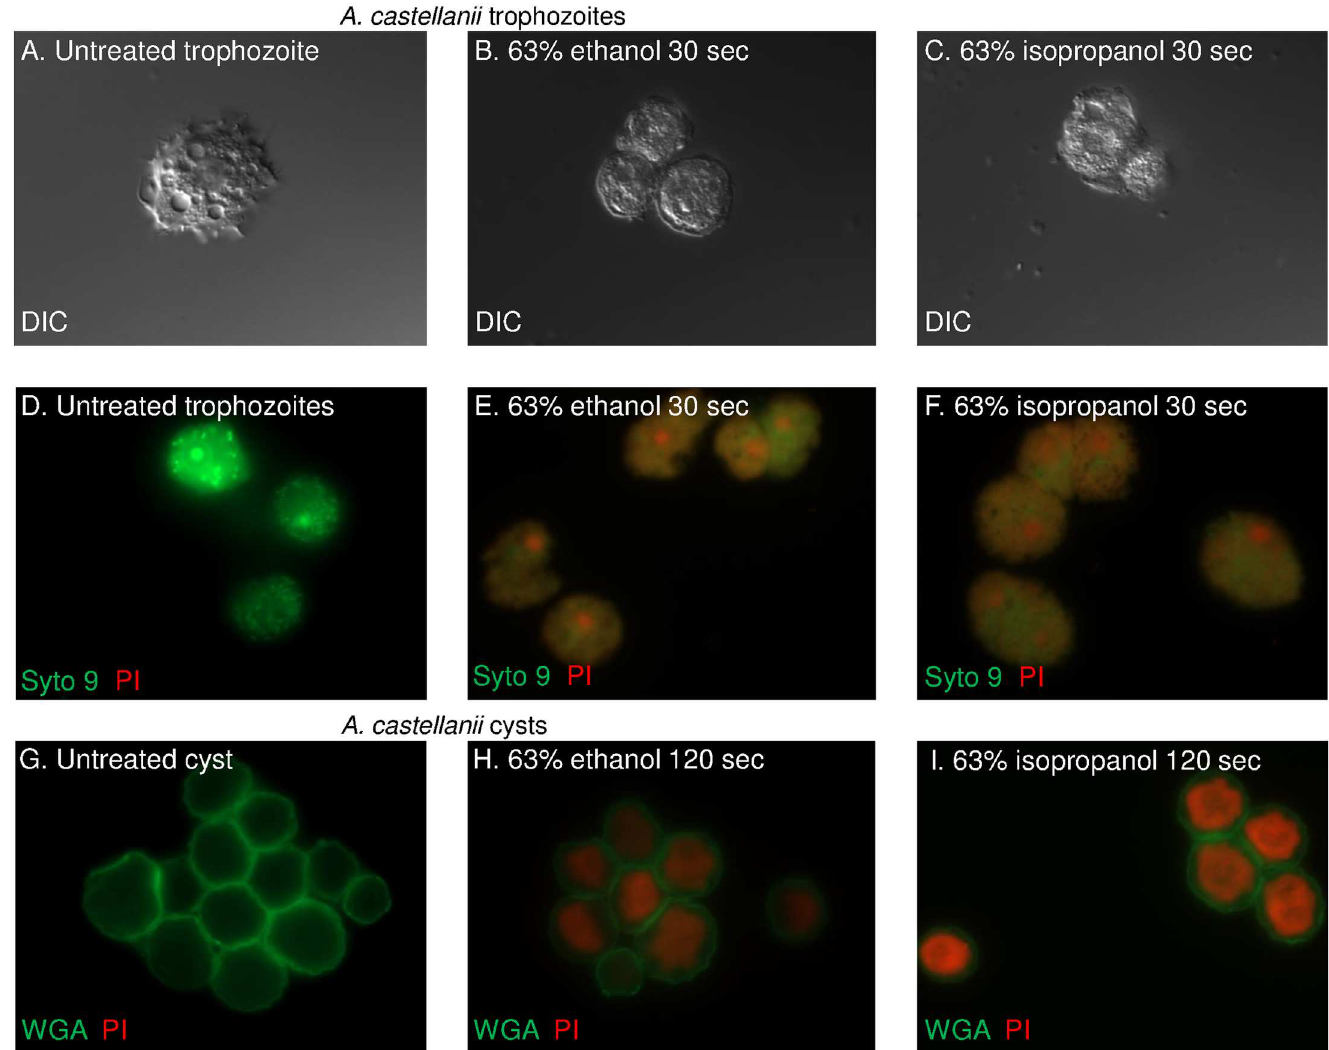
Fig 1. A . castellanii trophozoites and cysts are rapidly permeabilized and killed by ethanol and isopropanol. (A) Differential interference contrast (DIC) micrograph shows that untreatedtrophozoites have prominent vacuolesand acanthopods. In contrast, trophozoites treated with 63% ethanol(B) or 63% isopropanol(C) for 30 sec are roundedand have lost acanthopods. Not captured in still photographsis mobility of untreated trophozoites versus absenceof mobility of alcohol-treated trophozoites. (D) Fluorescence micrographof untreated trophozoitesshows that Syto 9 (green), a vital stain, readily penetrates the plasma membrane, whilePI (red stain in live-deadkits) does not. In contrast, both Syto 9 and PI readily label trophozoiteskilled by incubation in ethanol(E) and isopropanol(F). Wheat germ agglutinin(WGA in green) labels glycoproteins in the walls of both untreated(G) and alcohol- treated cysts for 120 sec (H and I). PI (red) does not label untreatedcysts but readily penetrateswalls and plasma membrane of alcohol-treated cysts. All images are of A . castellanii MEI 0184 strain and were shot through the 100X